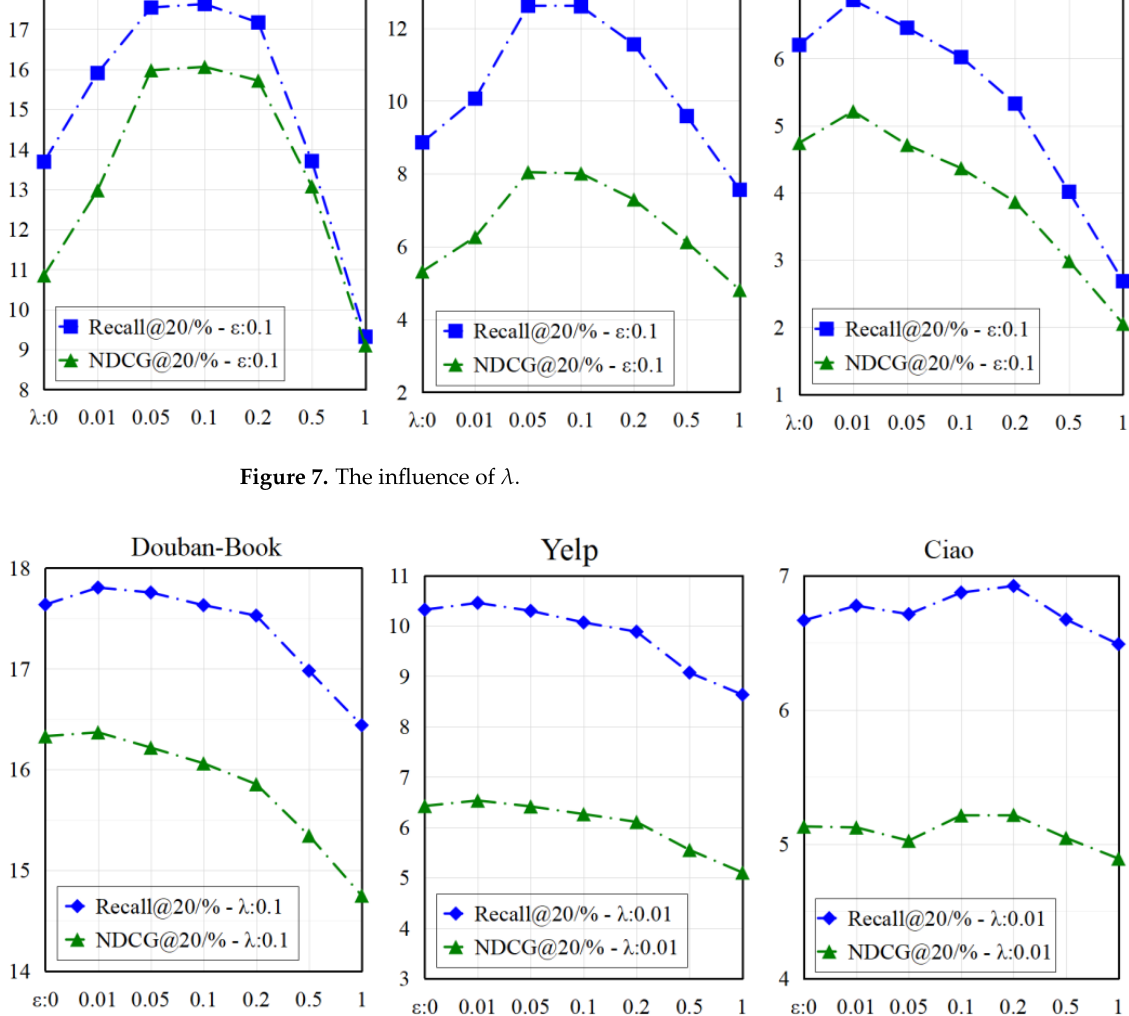
Figure 7. The influence of λ .